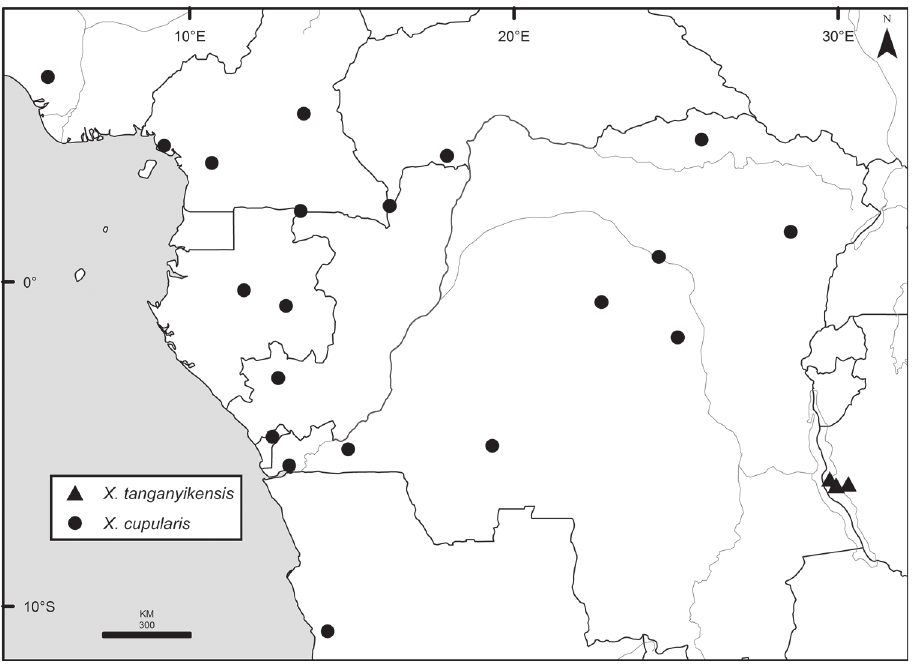
Figure 38. Distributions of Xylopia cupularis and X. tanganyikensis . Bolder lines represent country bor- ders, fainter lines lakes and major